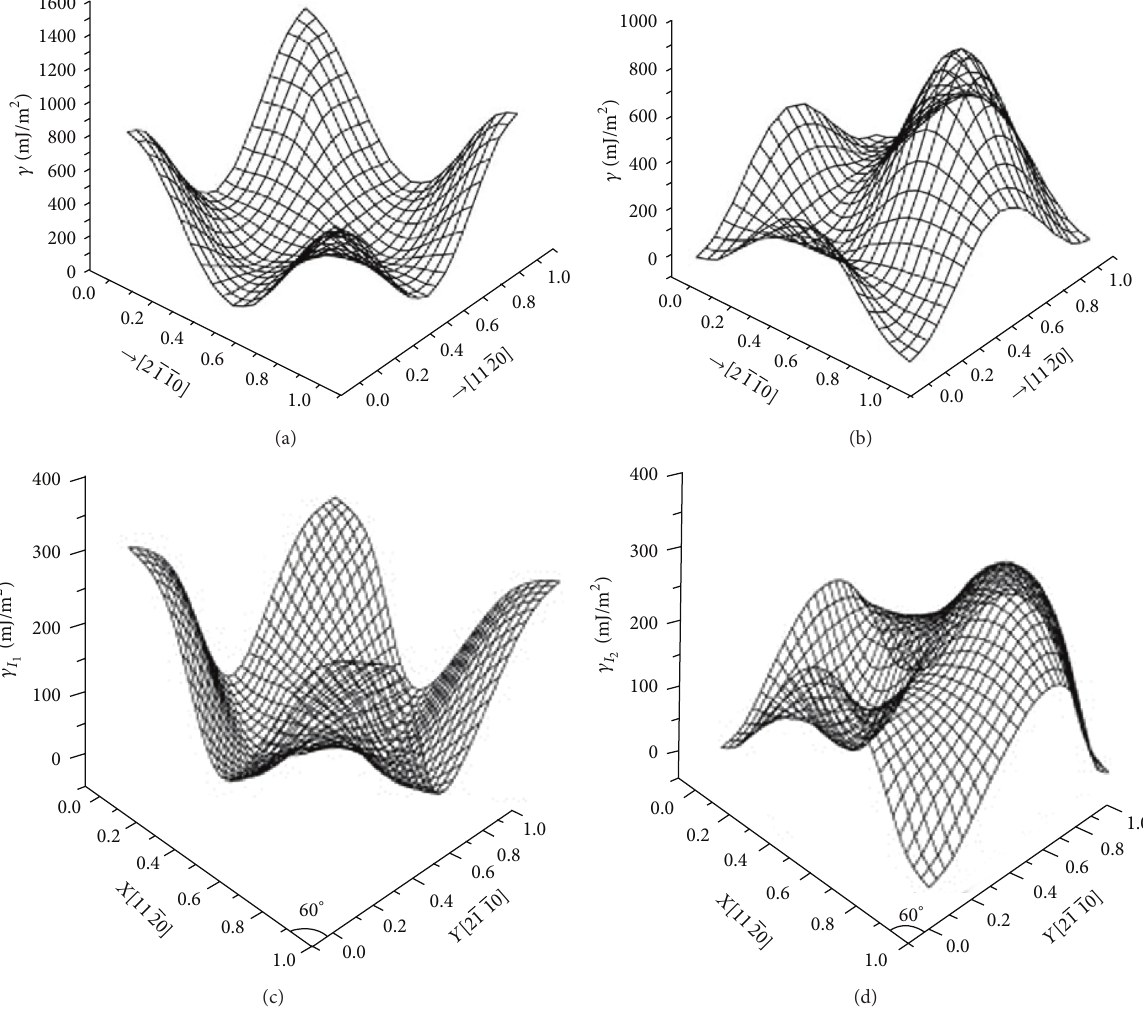
Figure 3: The 𝛾 -surface of basal plane stacking faults 𝐼 1 of Mg (a), 𝐼 2 of Mg (b), 𝐼 1 of Mg-Y (c), and 𝐼 2 of Mg-Y (d). Plots (a) and (b) are adapted from [28]; plots (c) and (d) are adapted from